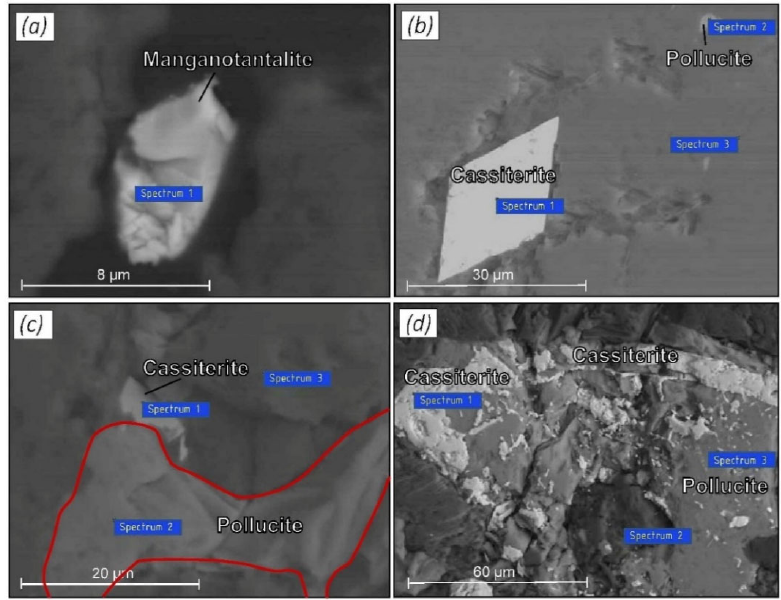
Figure 7. Mineral microinclusions in pollucite pegmatites: manganotantalite ( a ), cassiterite ( b ), pollucite and cassiterite ( c ), and cassiterite strings in pollucite ( d ).